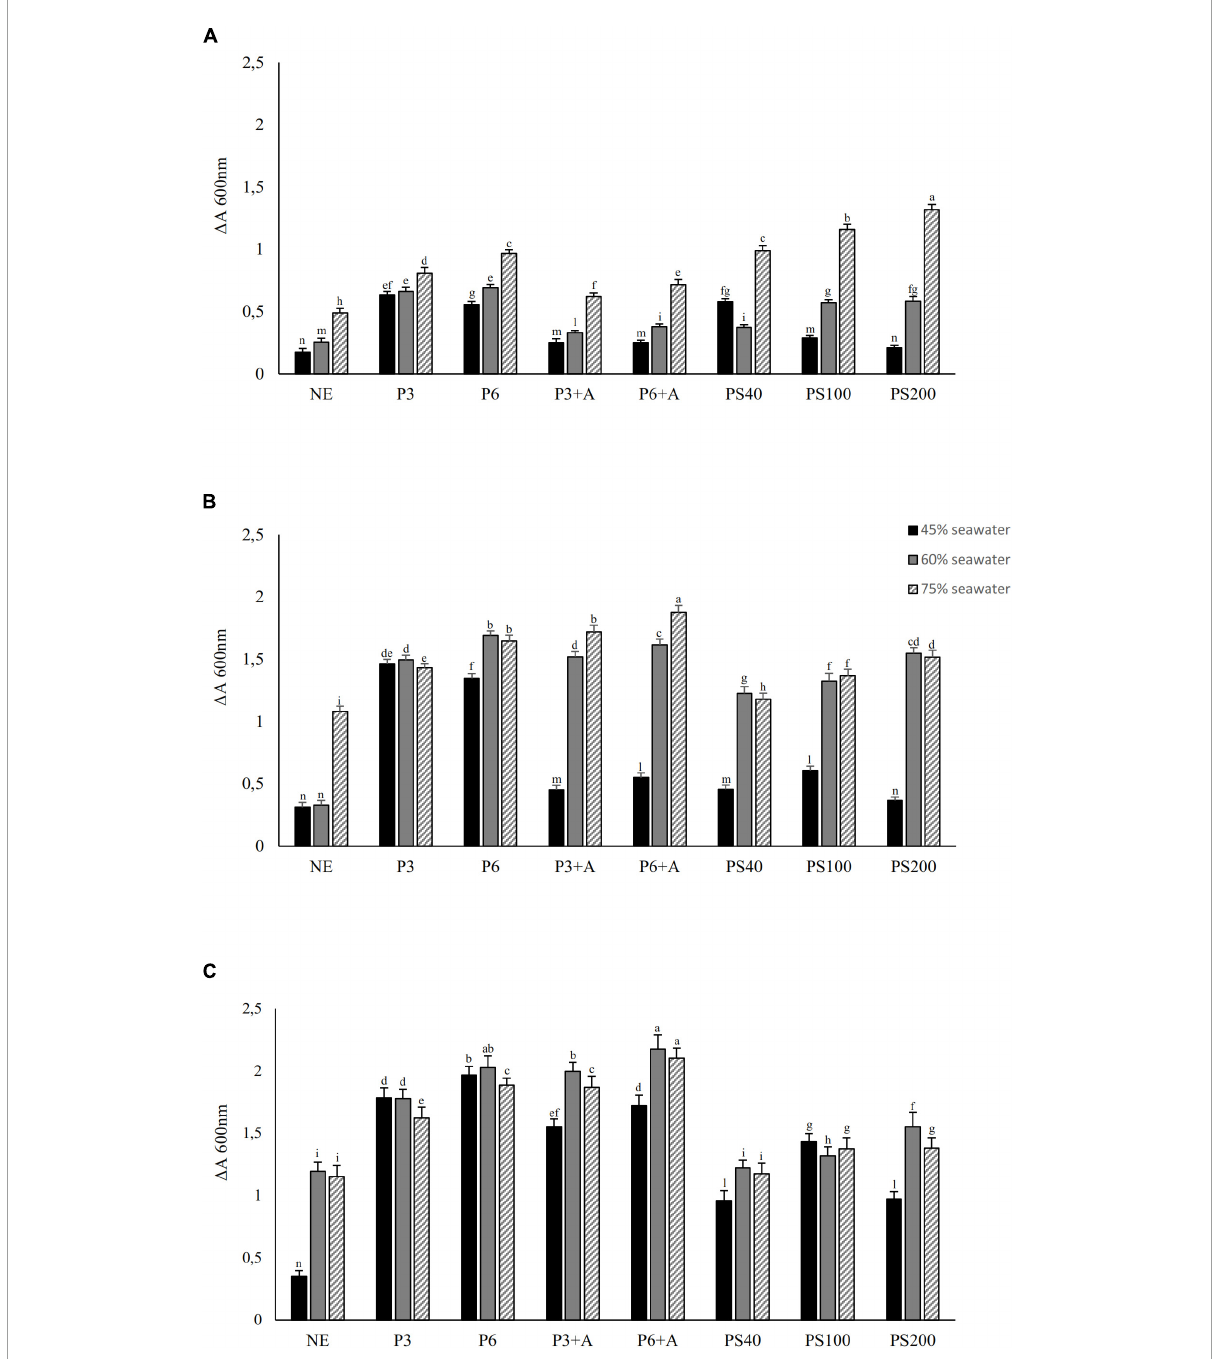
FIGURE2 Growth tests of Hfx. mediterranei DSM1411 (values expressed as absorbance, (cid:49) A at 600 nm) on different wasted bread substrates obtained without enzyme treatment (incubation 1 h at 4 ◦ C), after pepsin treatment at 37 ◦ C for 3 or 6 h (P3 or P6, respectively) (3 mg/g of bread, pH solution of 2.5), α -amylase treatment at 37 ◦ C for 3 h (A) (5 mg/g of bread, solution pH of 6.9), or after sequential treatment with both the enzymes (P + A). Bread homogenates subjected to a treatment (37 ◦ C for 6 h) with commercial protease formulation Veron PS was also included (40, 100, and 200 g/100 kg bread; respectively PS40, PS100, and PS200). A wasted bread homogenate was prepared without enzymes (NE). Seawater was added at 45, 60, and 75%vol/vol. All substrates were added with 160 g/L of NaCl and brought to pH 7.2 with 1M ammonia solution before inoculum of 7 log10 cfu/mL. Cell density was detected as a difference between the start of incubation (37 ◦ C in stirring condition) and 24 (A) , 48 (B) , or 72 h (C) . The data are the means of three independent experiments ± standard deviations ( n = 3). a − n Values with different superscript letters differ significantly ( p <